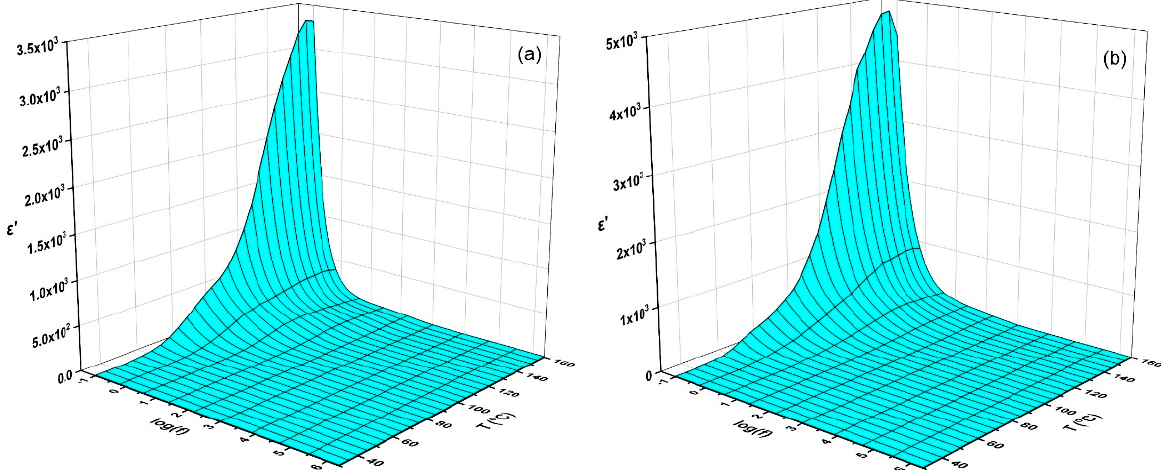
Figure 4. Real part of dielectric permittivity as function of frequency and temperature for: ( a ) unfilled epoxy and ( b ) 5 phr TiC/5 phr BN/epoxy nanocomposite.